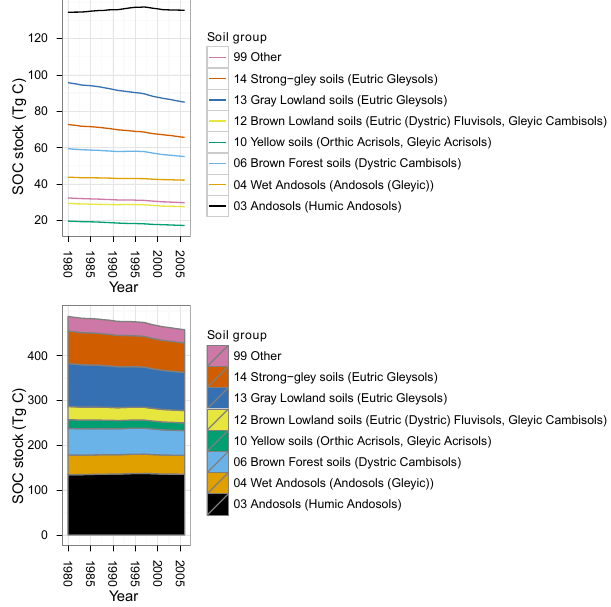
Figure 5. Simulation output on changes in soil organic carbon (SOC) stocks in agricultural lands in Japan. Top panel shows SOC stock in seven selected major soil groups and other soil groups. Bot- tom panel shows both the total sum and individual value of SOC stock in each of those soil groups as a stacked area graph. Note that the selected seven major soil groups accounts for 88% of total area of all 16 soil groups in Japan, according to Obara (2000).